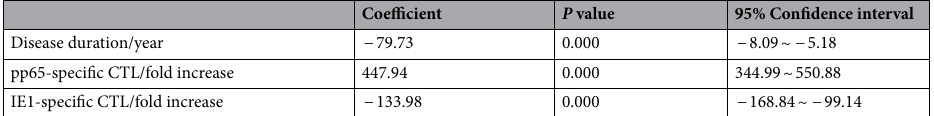
Table 3. Association of virus-specific CTL and corneal endothelial cell loss by mixed linear regression analysis.